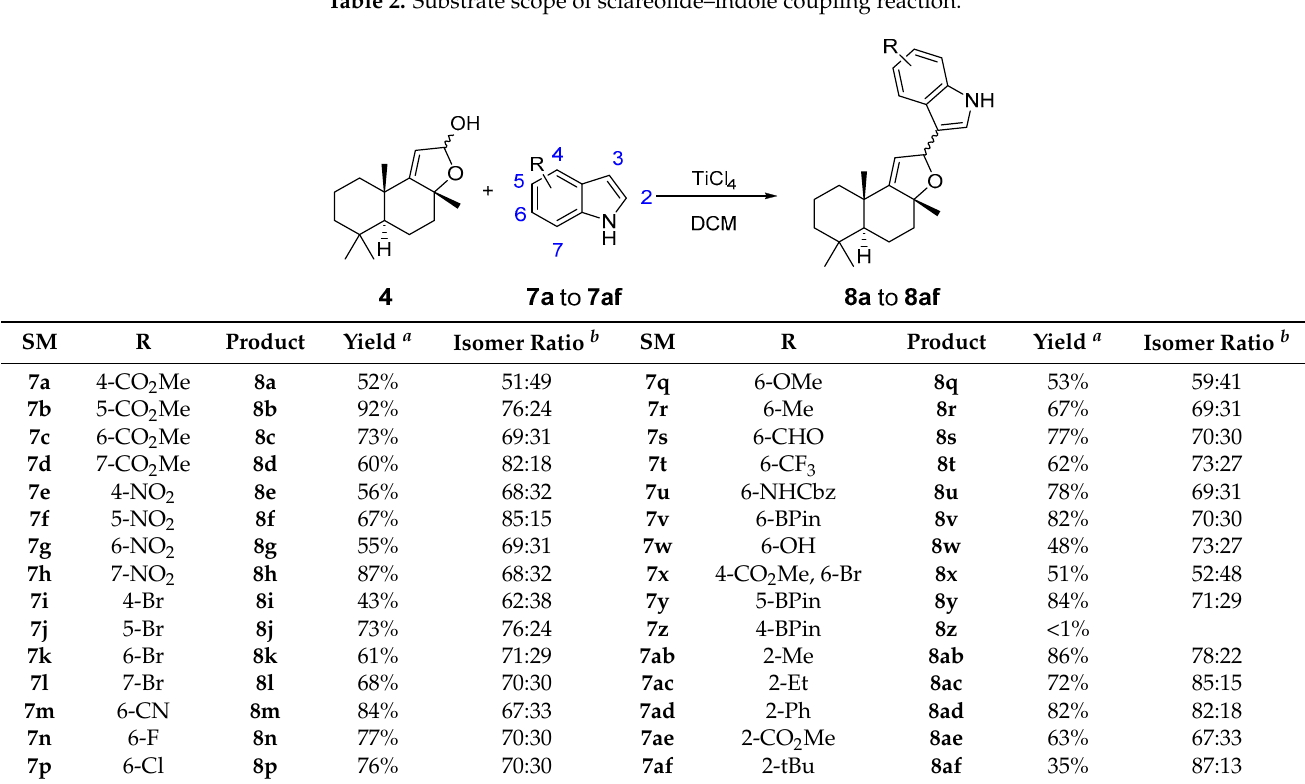
Table 2. Substrate scope of sclareolide–indole coupling reaction.